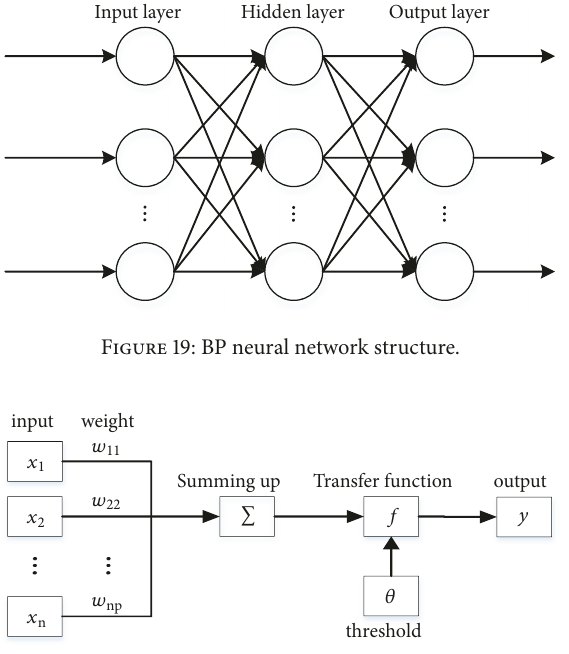
Figure 20: Artificial neuron